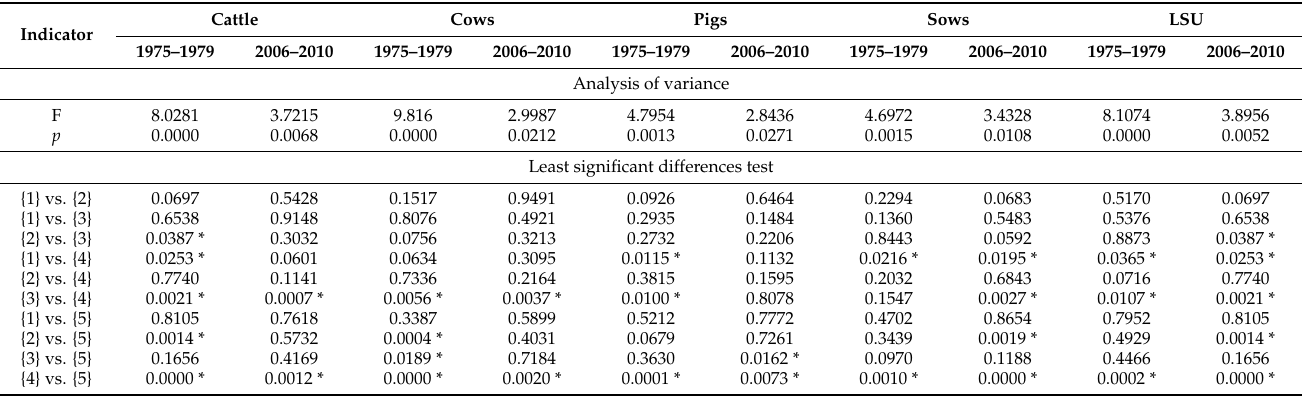
Table 6. Results of the analysis of variance regarding the significance of the differences in livestock for specific districts at the beginning and the end of the analyzed period (average for five